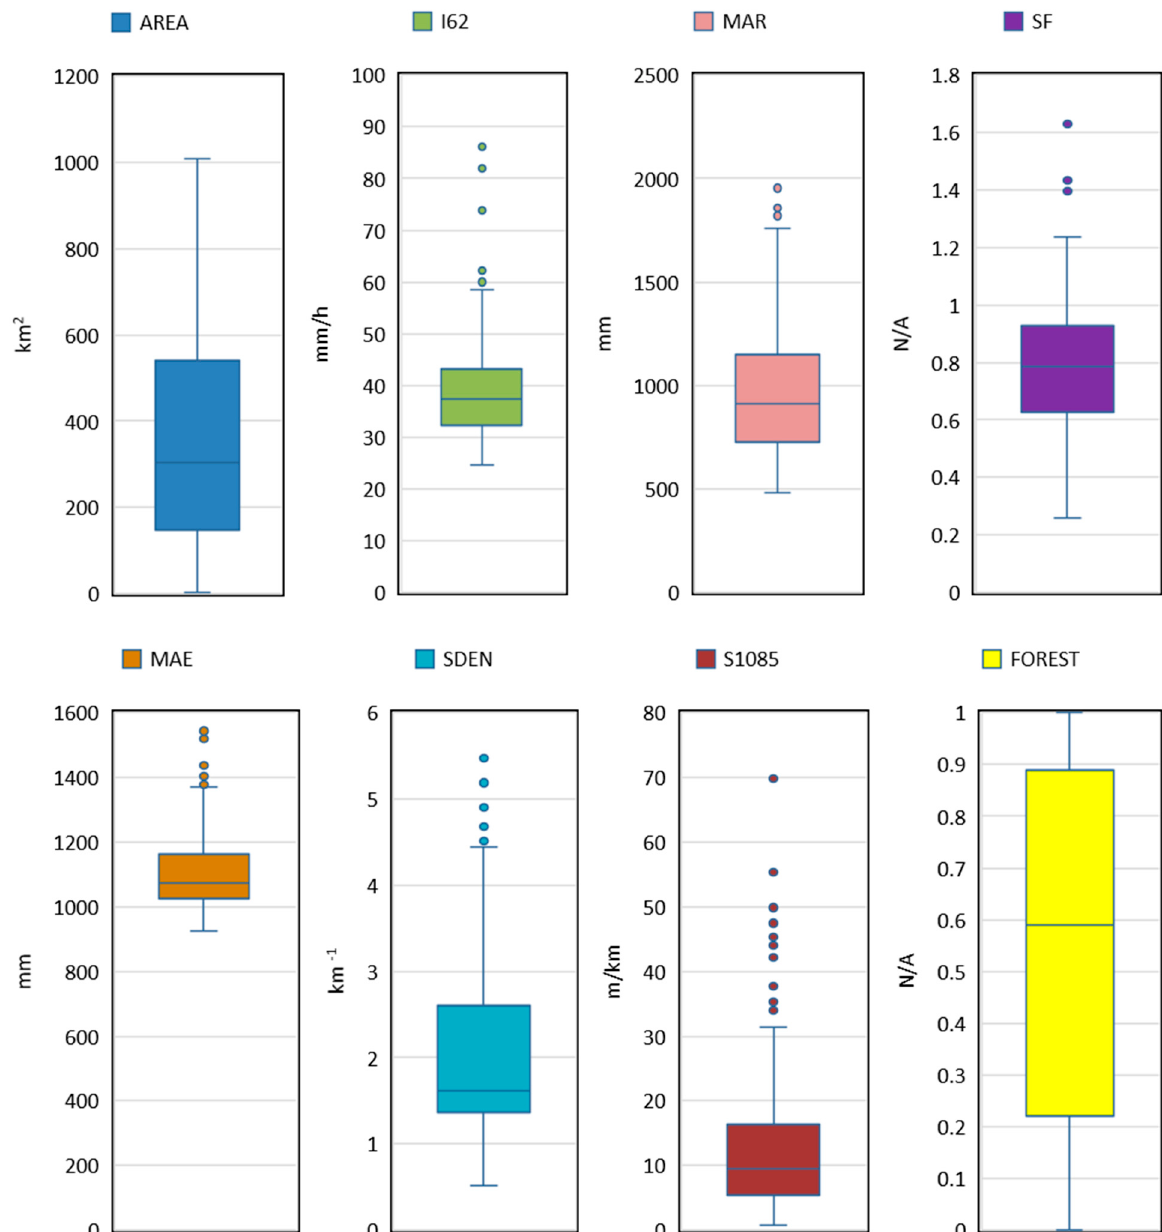
Figure 2. Boxplots of candidate eight predictor variables.